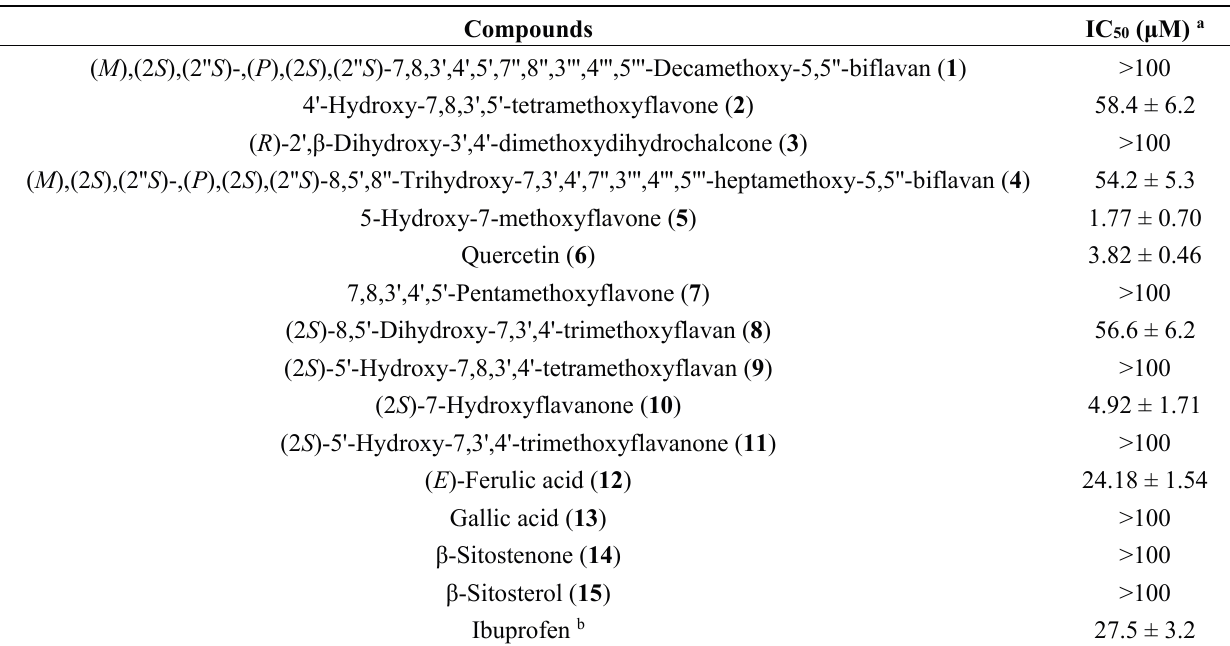
Table 4. Inhibitory effects of compounds 1 – 15 from the stem wood of M. calabura on superoxide radical anion generation by human neutrophils in response to fMet-Leu-Phe a .